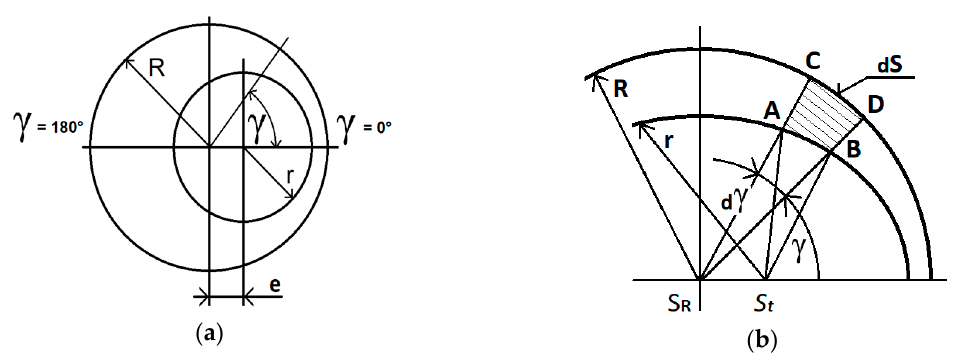
Figure 9. The tube eccentricity ( a ); the elementary surface on cross-section of eccentric tube ( b ).